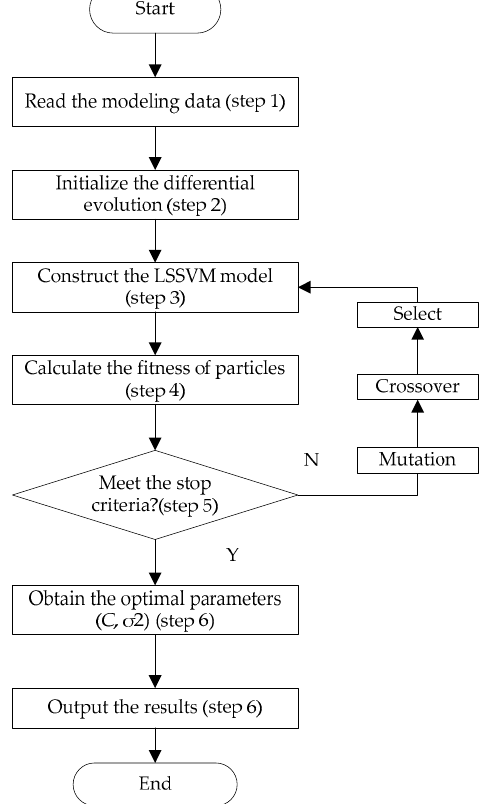
Figure 2. Flowchart of the differential evolution-based least square support vector machine ( DELSSVM) algorithm.